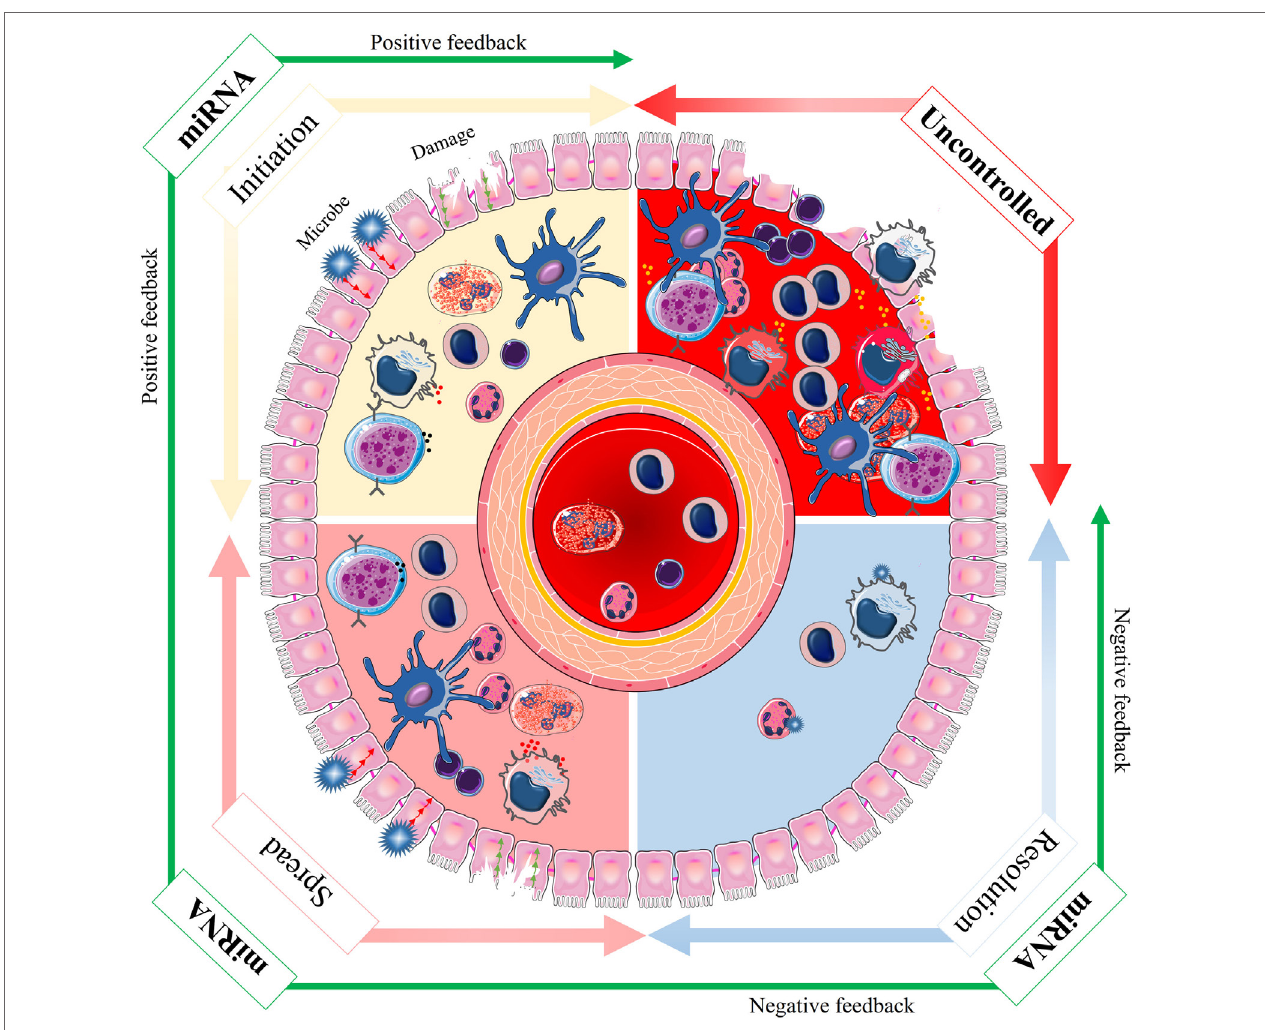
FigURe 3 | The spectrum of microRNA (miRNA) effects during inflammation. Inflammation is a complex biological and pathophysiological response in vascular tissues to noxious stimuli, such as infection and tissue damage. The initiation, spread, and resolution steps of inflammation are subject to both positive and negative regulatory events via miRNAs to achieve an optimal immune response (green arrow). The positive feedback is activated to initiate a cascade of molecular events that leads to combat invading microbial pathogens and successful repair of tissue damage. The negative feedback is only activated during severe inflammation and may be vital in preventing potentially dangerous and excessive inflammation. Lack of appropriate initiation or spread impedes the innate immune response, and lack of correct resolution can lead to uncontrolled condition and disease (red arrow). Thus, the molecular networks based on miRNAs that regulate the initiation, spread, and resolution of inflammation must be appropriately tuned for optimization of the innate immune